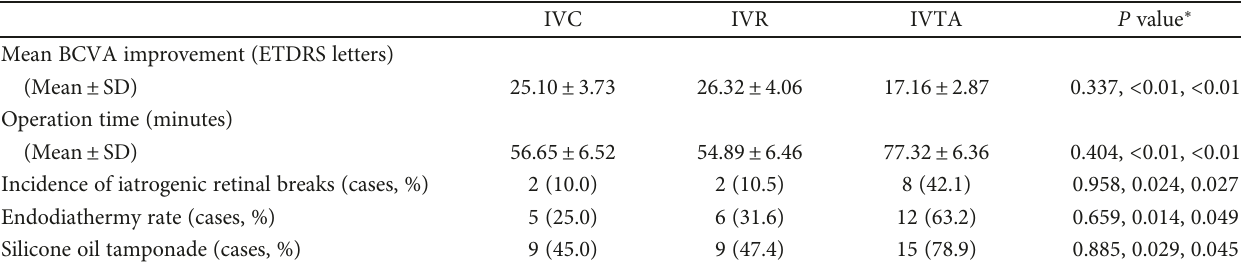
Table 3: Primary outcomes (Mean ± SD).